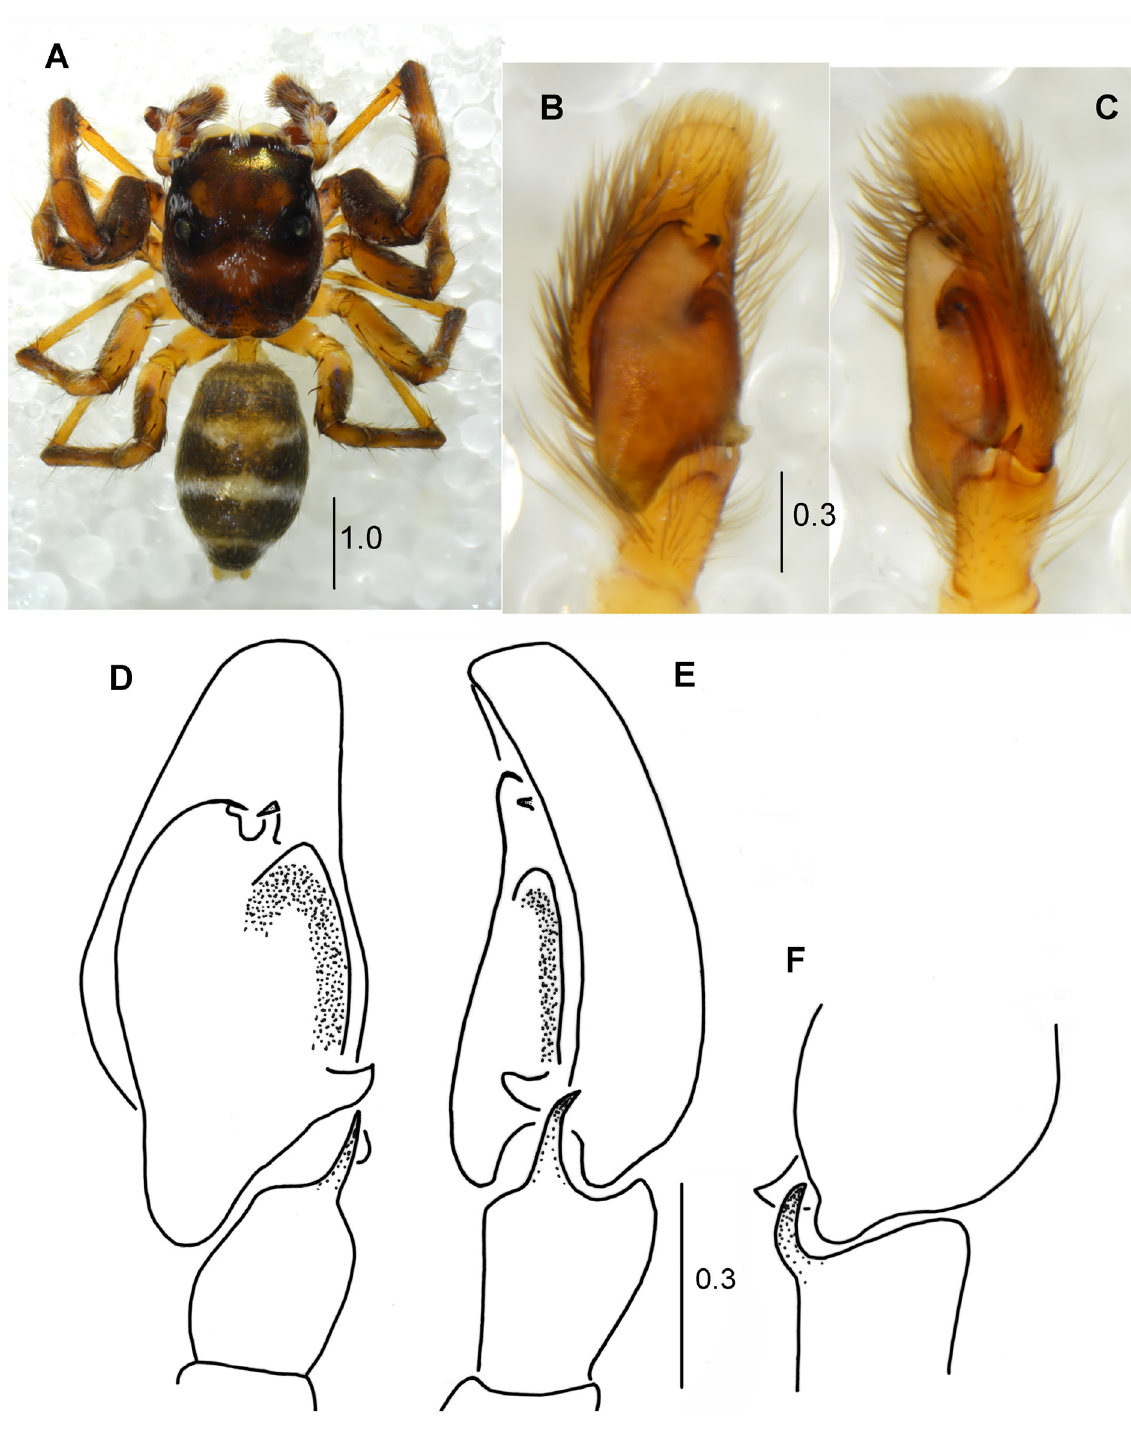
Fig. 49. Phintella transversa sp. nov., paratype, ♂ (MNHN). A . Habitus, dorsal view. B, D . Palpal organ, ventral view. C, E . Palpal organ, lateral view. F . Tibial apophysis, dorsal